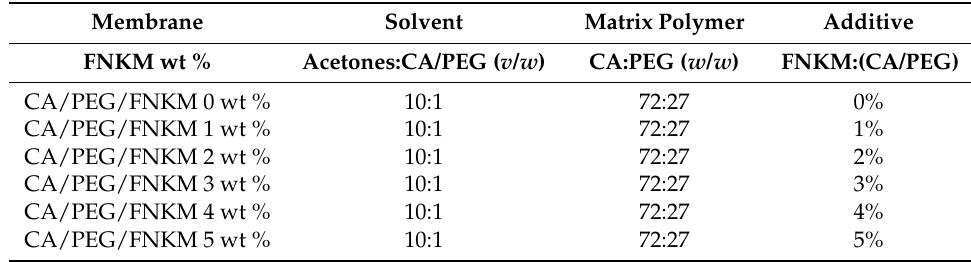
Table 3. Compositions of the prepared solution used in casting CA/PEG/FNKM composite membranes. PEG: Polyethylene